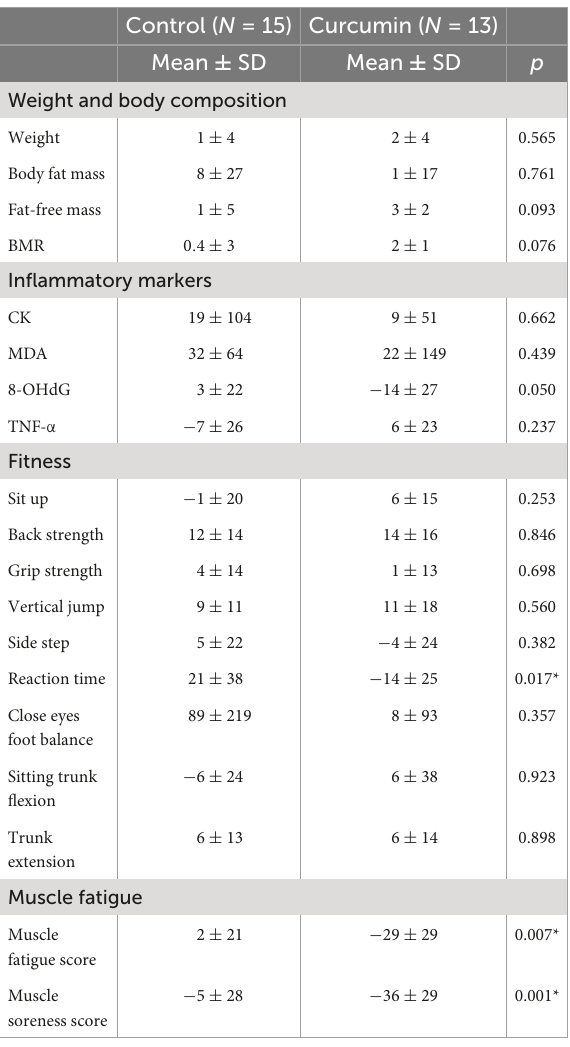
TABLE 3 Percentage change of body composition, inflammatory markers, fitness, and muscle fatigue between baseline and the end of study (12